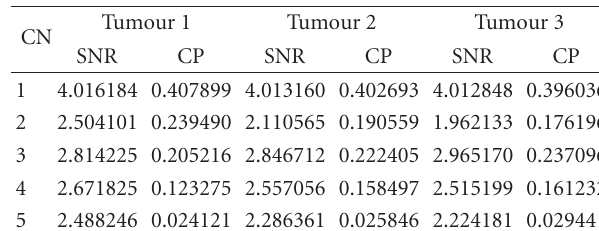
Table 6: SNR and CP for tumours 1, 2 and 3 in the simulated phantom data set with nonisotropic voxels.